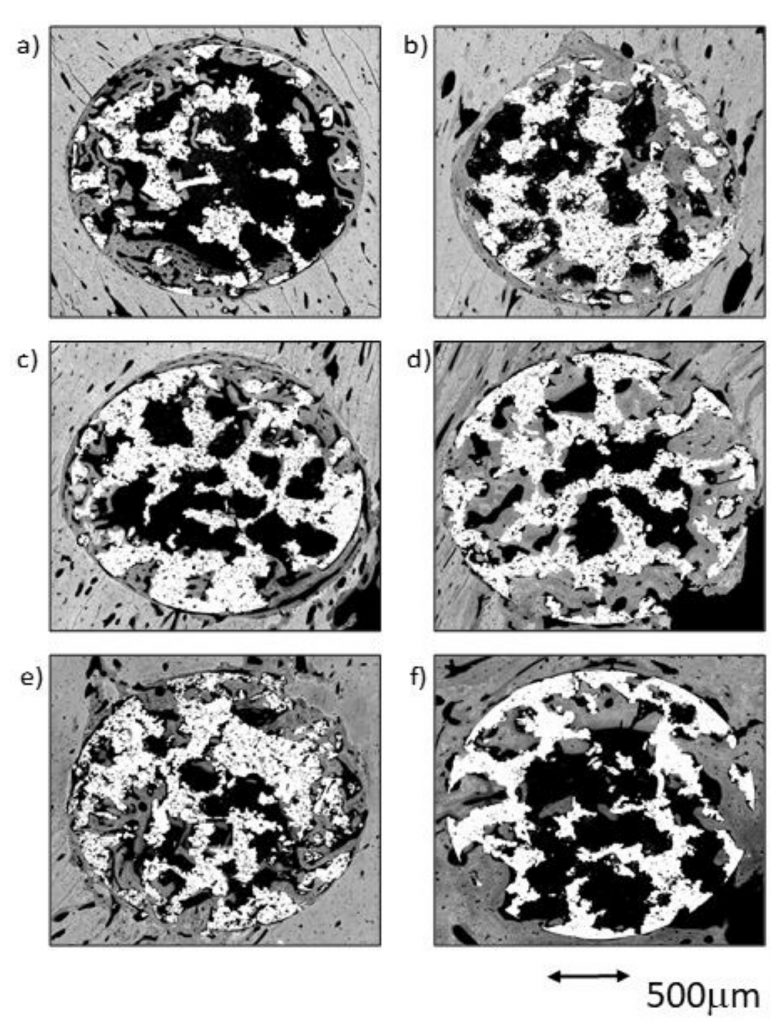
Figure 3. BSE-SEM results 4 weeks (left) and 12 weeks (right) after porous titanium implant insertion in transversal view: ( a , b ) CG; ( c , d ) TCG; ( e , f ) PAG.